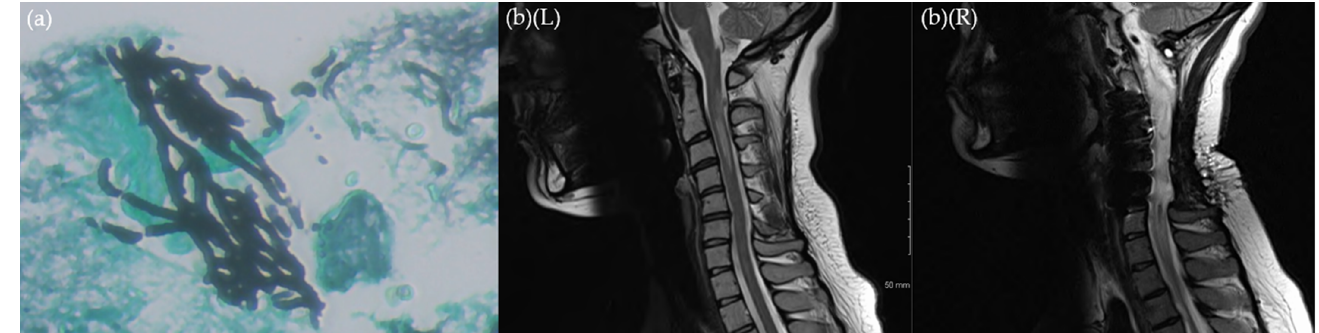
Figure 2. ( a ) Grocott stain of excised spinal cord mass in February 2018 showing septate branching hyphae, also PCR + for A. fumigatus; ( b ) sagittal C ‐ spine MRI findings at baseline August 2017 ( L ) and at end of treatment June 2021 ( R